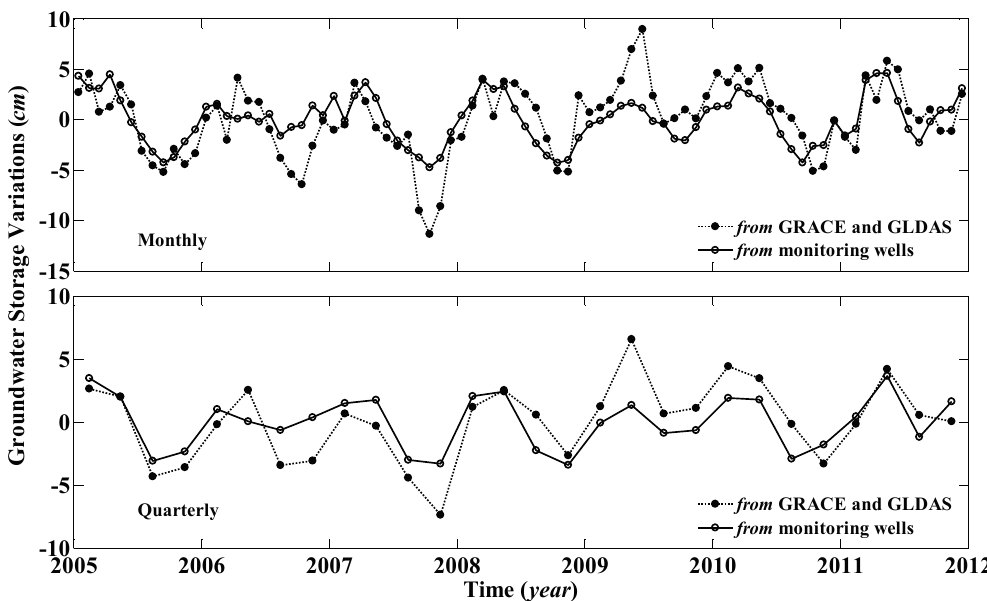
Figure 5. Comparisons of monthly and quarterly variations between GRACE-GLDAS based groundwater and in-situ monitoring well observations.